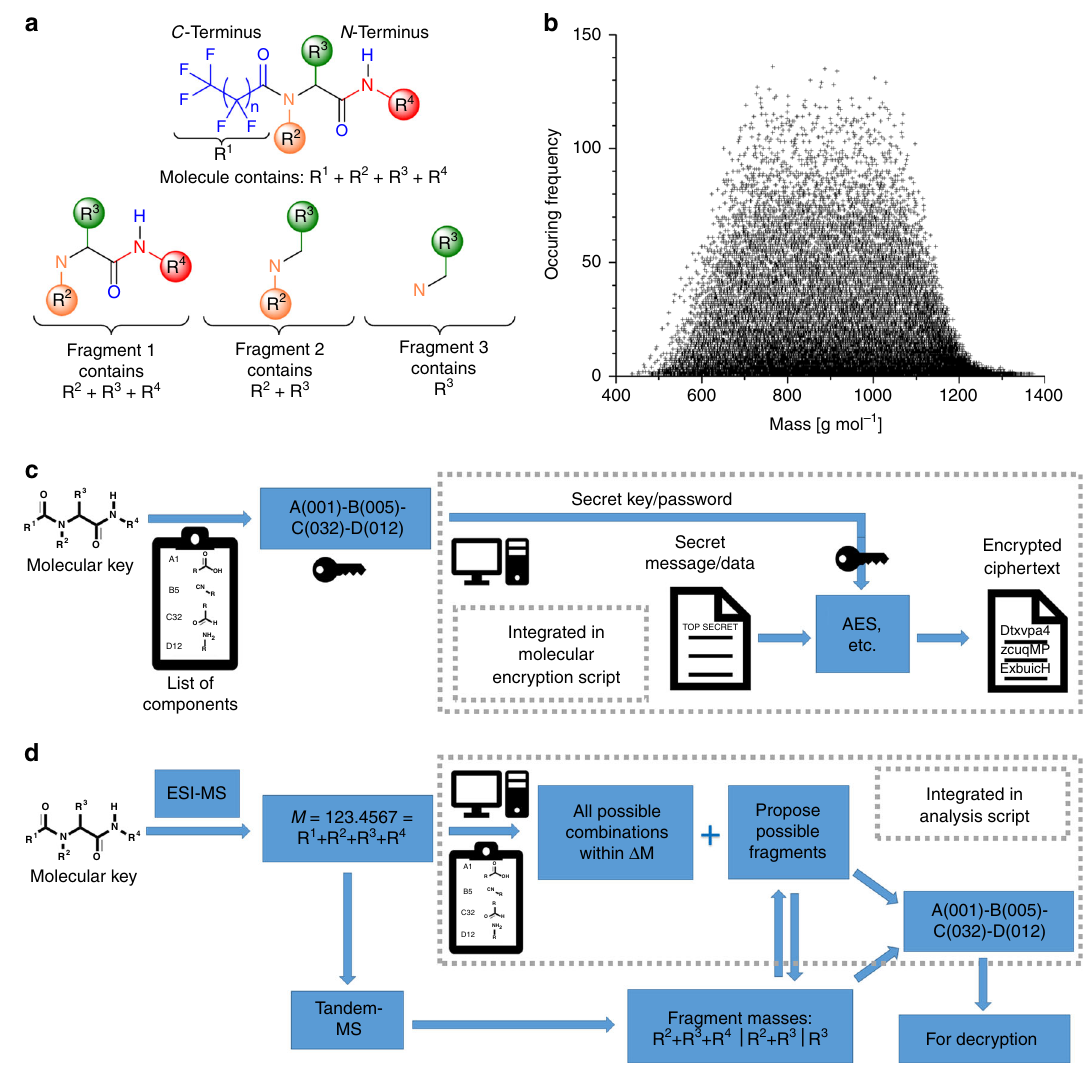
Fig. 5 Cryptography integration of molecular keys. a Schematic representation of fragments, which can be used for the read out. Four masses are used for determining the sidechains R 1 – 4 . b Database evaluation of the most probable masses occurring within a Δ M threshold of 0.01 Da. The possibilities are reduced from 500,000 to a maximum of 140 after entering the monoisotopic mass. c Schematic illustration of